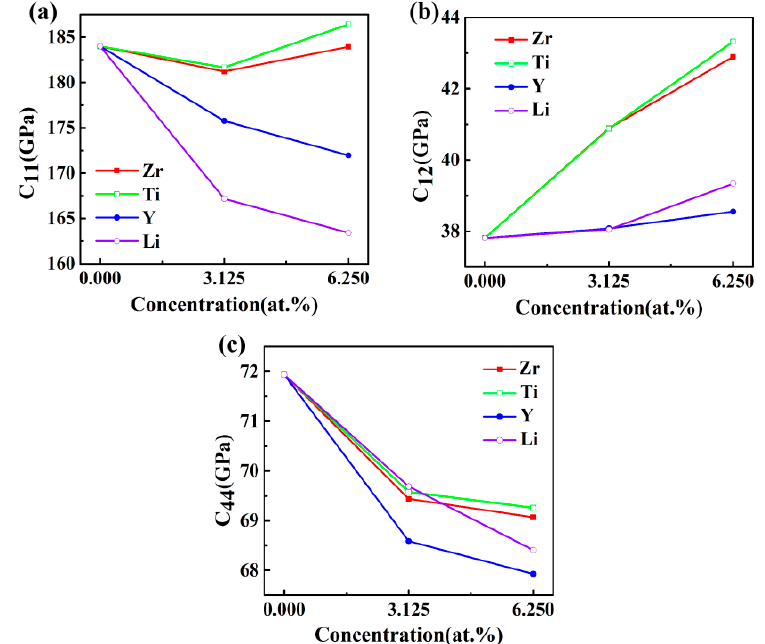
Figure 2. The elastic constants C ij (GPa) of L1 2 -Al 3 Sc doped with the element M (M = Zr, Ti, Y, and Li) on the dependence of doping concentration: ( a ) C 11 , ( b ) C 12 , and ( c ) C 44